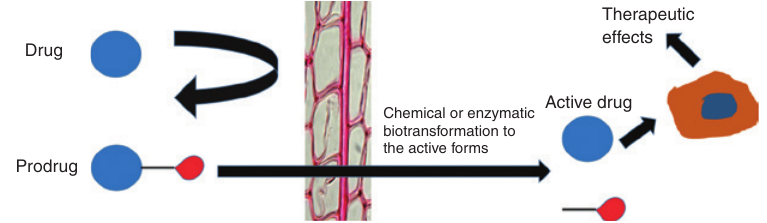
Figure 7: Schematic illustration of